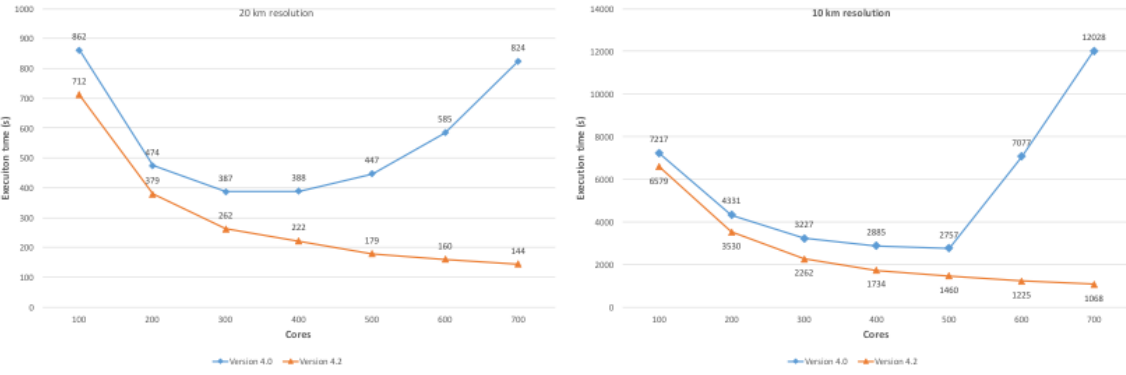
Figure 20. Execution time reduction at the UNA machine on 20 and 10km grid spacing model configurations.